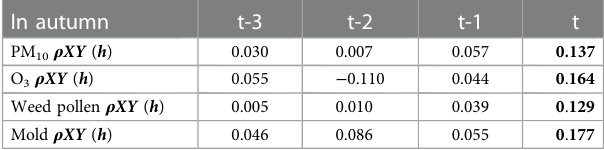
Bold values represent highest cross-correlation coef fi cients. t-n: n weeks ago.